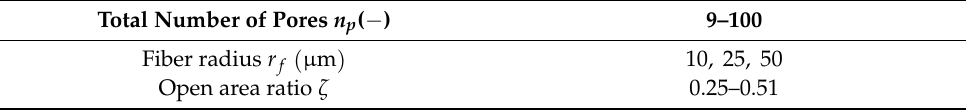
Table 2. Geometric properties of the wire mesh